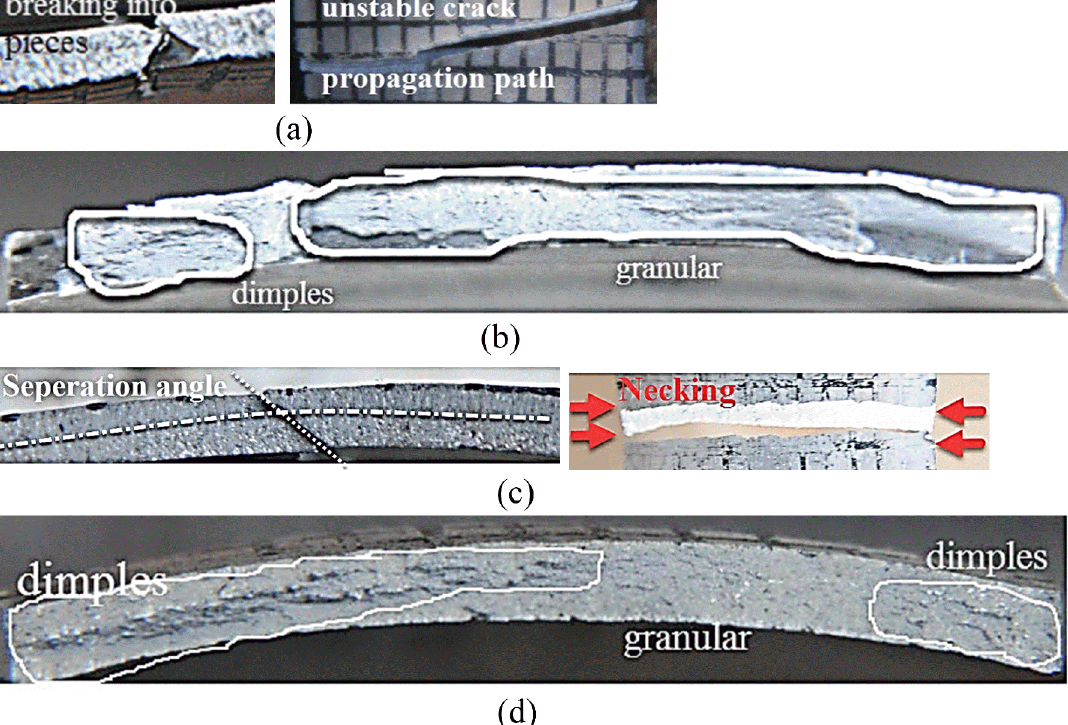
Figure 22. Photographs of fracture surfaces, a) Crack propagation path of AA7075-T6, side and front of sample, b) Cross section of ruptured surface of AA7075-T6, c) Crack propagation path of AA7075, dissolved at 500 ºC, side and front of sample, d) Cross section of ruptured surface of AA7075, dissolved at 500